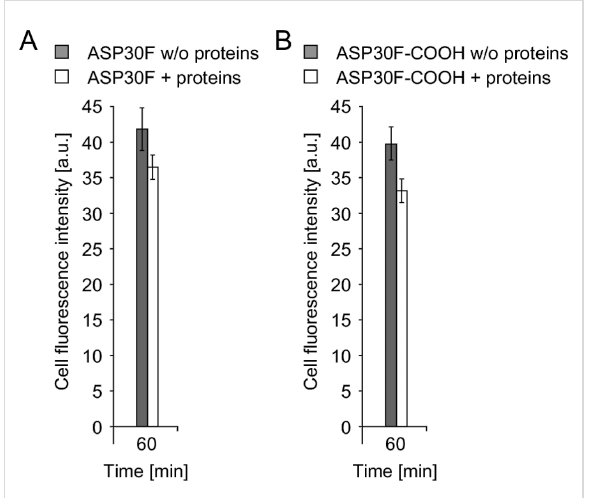
Figure 7: Uptake of fluorescently labeled ASPs. (A/B) Automated microscopy to quantify time-dependent cellular uptake of fluorescent amorphous silica nanoparticles (ASP30F (A) and ASP30F-COOH (B)). CaCo-2 cells were exposed to the nanoparticles (100 µg/mL) suspended in DMEM (filled rectangles) or DMEM containing 10% human plasma (open rectangles) for 60 min. Total cellular fluores- cence is displayed as arbitrary units (AU). Assays were performed in triplicates. Columns, mean; bars, ± SD from three independent experi- ments.